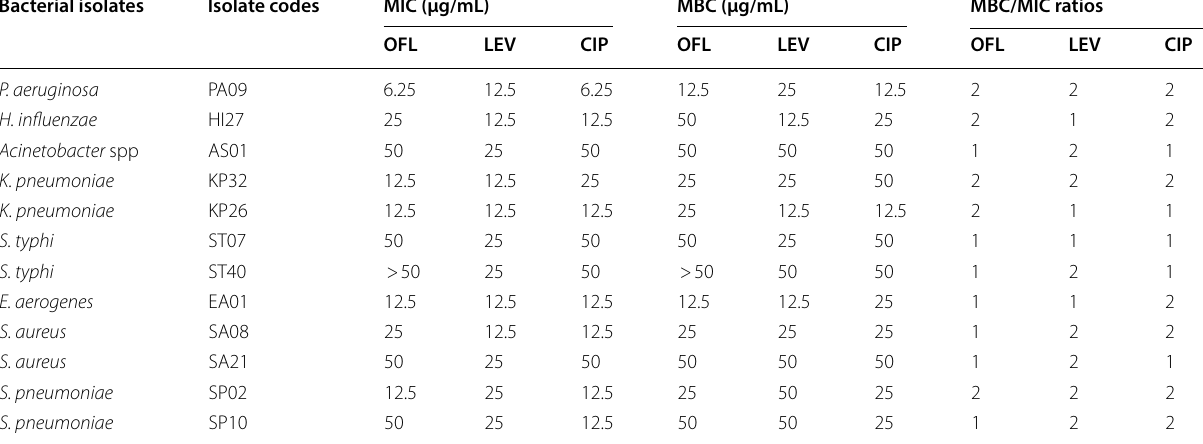
MIC Minimum inhibitory concentration, MBC minimum bacteriocidal concentration, OFL Ofloxacin, LEV Levofloxacin, CIP Ciprofloxacin pneumoniae SP02 at 30 h post-inoculation, while